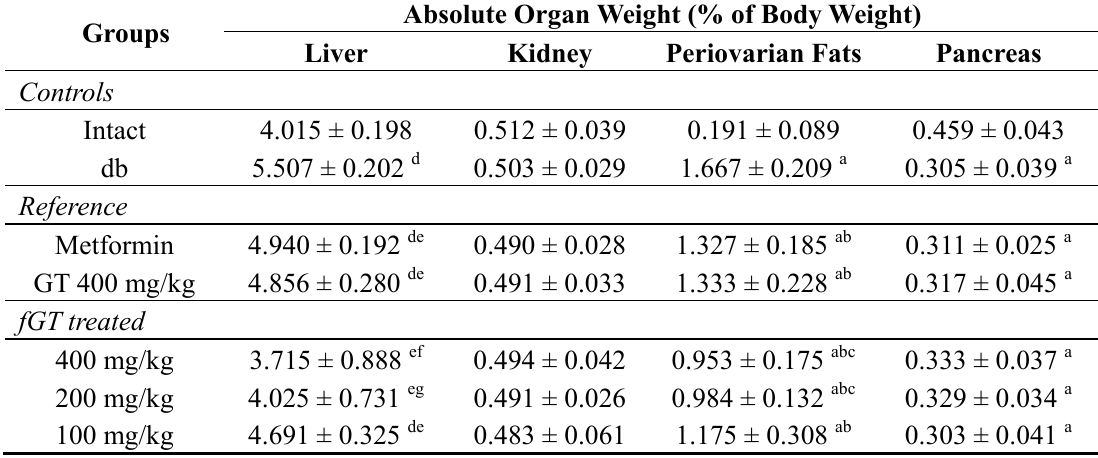
Table 4. Changes on relative organ weight in intact normoglycemic and db/db